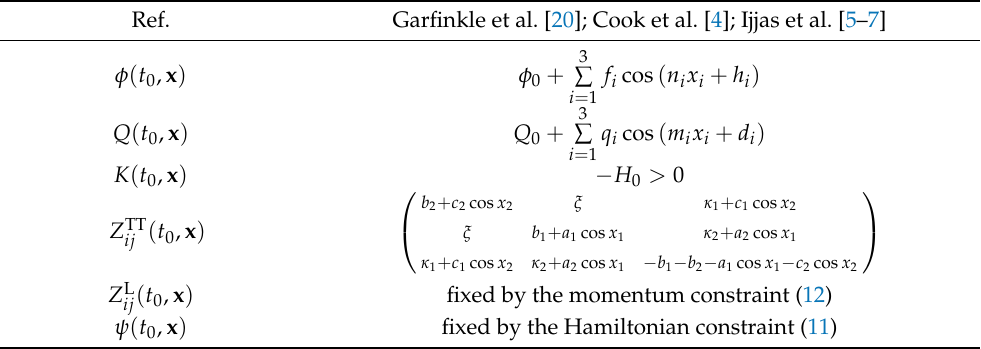
Table 1. Initial conditions in robustness studies of slow contraction determined by fixing 30 or more parameters. The scalar field φ , its velocity Q , the mean curvature K , the transverse, traceless component Z TT and the longitudinal component Z L of the shear tensor Z ij as well as the conformal ij ij factor ψ are specified at some initial time t 0 by fixing { φ 0 , f i , n i , h i , Q 0 , q i , m i , d i , H 0 , a j , b j , c j , κ j , ξ } ; i = 1,2,3 and j =